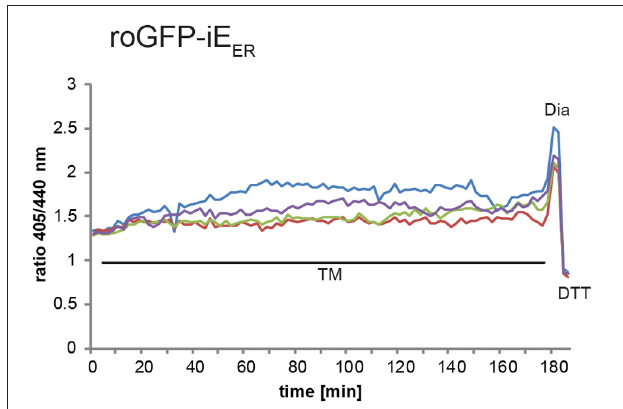
FIGURE 4 | Live imaging of roGFP1-iE ER upon tunicamycin treatment. HeLa cells transiently expressing roGFP1-iE ER were analyzed by ratiometric laser scanning microscopy 48h post-transfection. Where indicated, 1 μ g/ml tunicamycin (TM), 0.5mM diamide (Dia), and 20mM DTT were added to the specimen. The dynamic ratio changes of individual cells were plotted against